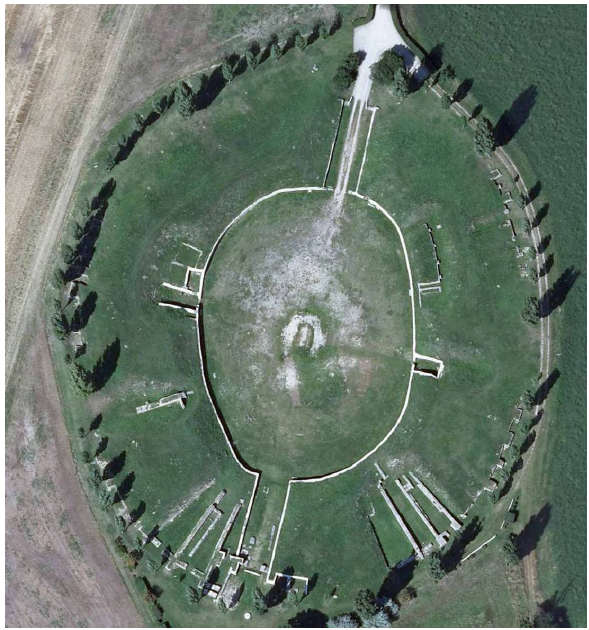
Figure 3: Detail of a pre-existing OPM of the civil amphitheatre of Roman Carnuntum, Austria, containing the foot-print of fig. 2 in the west, with vegetation in a different phenological state. etation is generally in a different phenological state and of a dif- ferent size, and cropland is in another phase of cultivation, with different marks of